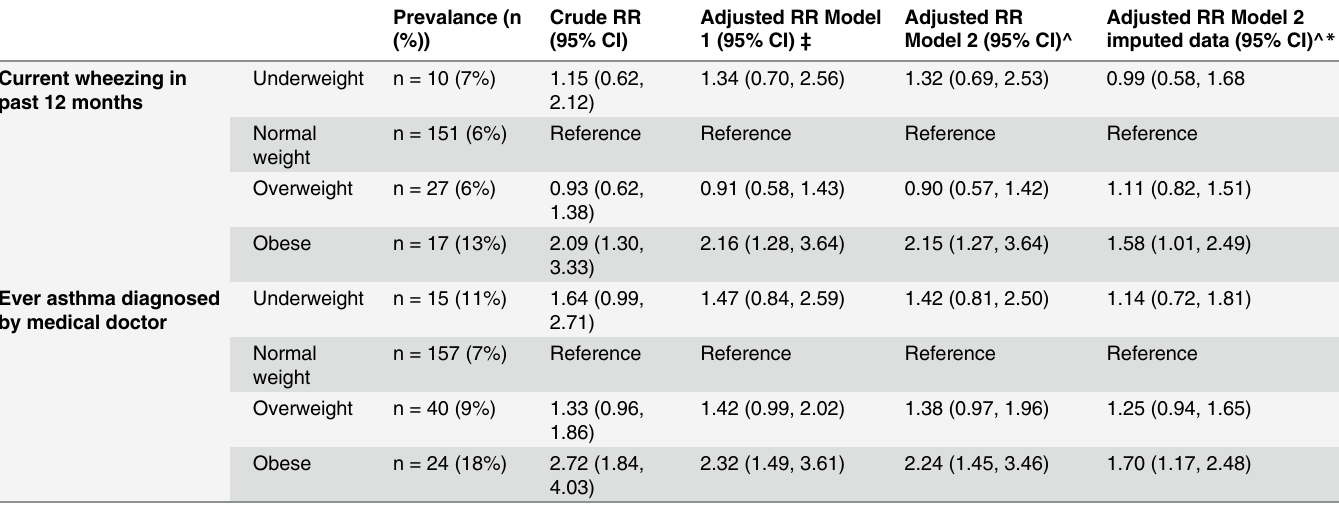
Table 2. RRs of respiratory outcomes at offspring age 7-8years in relation to maternal BMI (n = 3185).